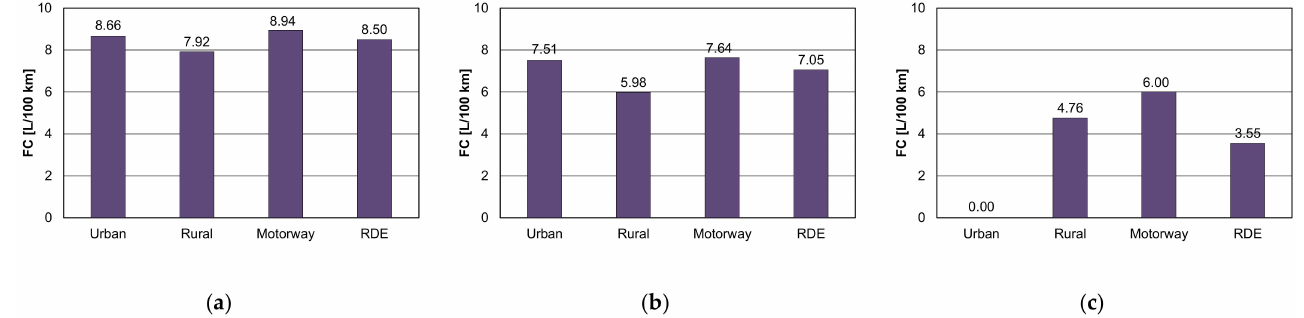
Figure 7. Results of tests of fuel consumption in a passenger vehicle with a gasoline engine ( a ), a diesel engine ( b ), PHEV ( c ).